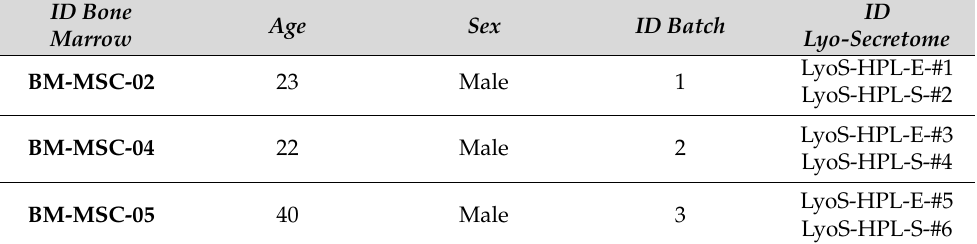
Figure 1. Study design summary. Alpha-MEM was added with HPL-E or HPL-S for MSC cell cultures ( A ). The culture supernatants were collected, ultrafiltered ( B ), and freeze-dried ( C ). The obtained lyo-secretome was analyzed for physico-chemical characteristics and used to perform immunomodulation experiments ( D ) to test the lyo-secretome biological activity. Table 1. Bone marrow samples collected with information on relative donors’ age and sex/gender, the ID of mesenchymal stromal cells cell lines (BM-MSC-02 04, 05) derived from BM samples and the ID of lyo-secretome isolated by BM-MSCs cultivated in HPL-E (LyoS-HPL-E #1, #3,#5) and in HPL-S (LyoS-HPL-S #2,